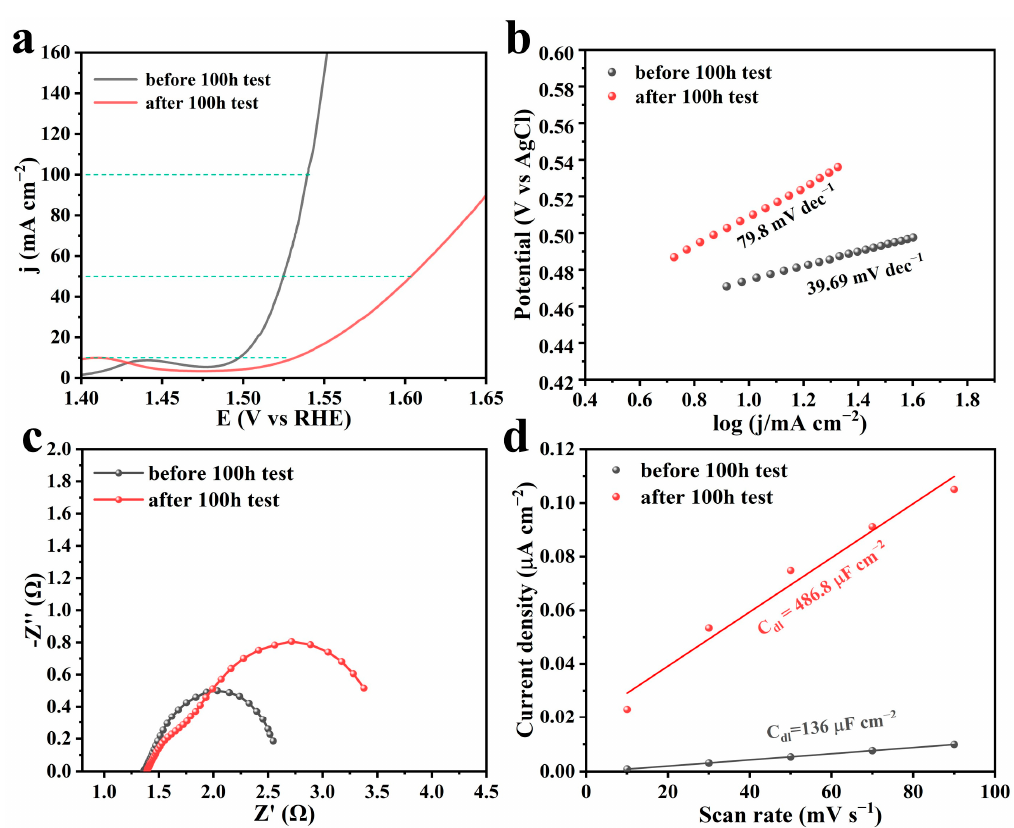
Figure 5. Electrocatalytic performance in 0.5 M NaCl + 1 M KOH of catalyst before and after 100 h chronoamperometry test. ( a ) LSV curves. ( b ) Tafel slope. ( c ) Nyquist plots. ( d ) C dl values.